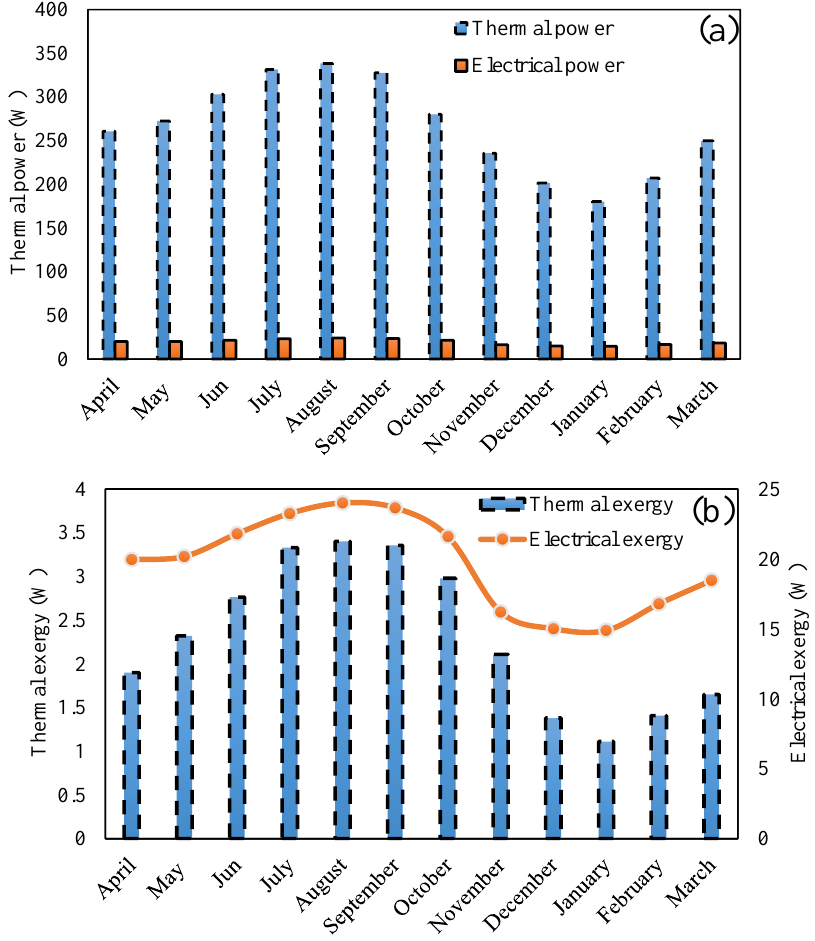
Fig. 14. Monthly performance of the PVT/(glazed)ST system from (a) energy and (b) exergy